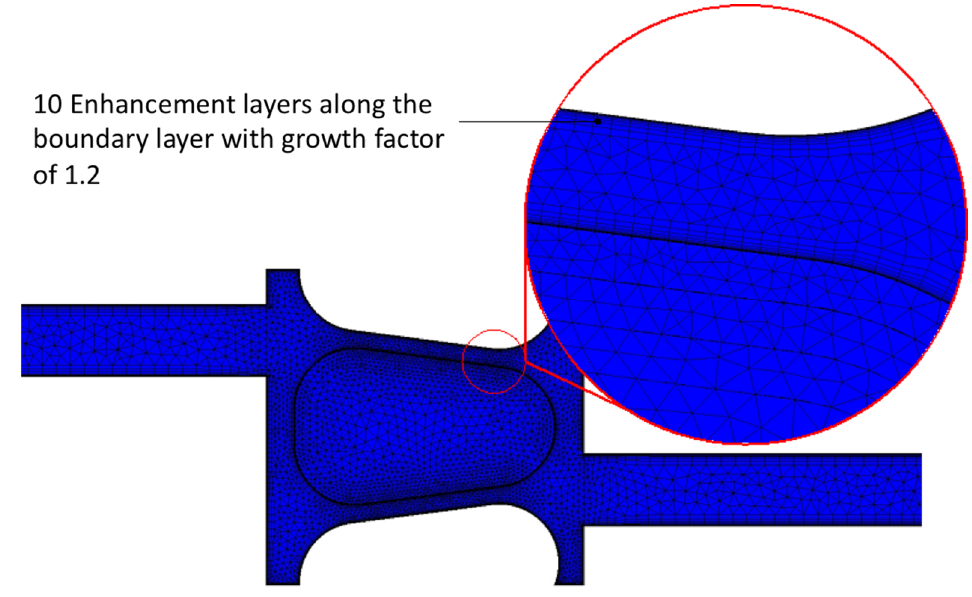
Figure 6. Mesh of the liquid channel in 3D CFD with details of the boundary layer.